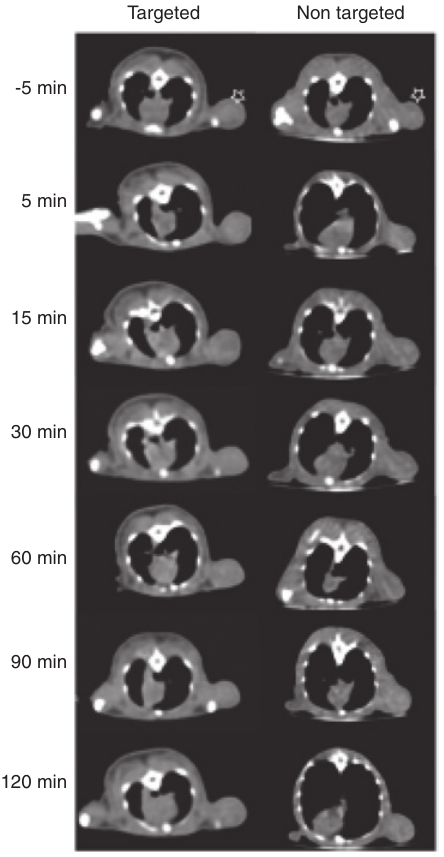
Figure 4: CT images of tumors before and after intravenous injec- tion of DSNP with (targeted, left) or without FA (nontargeted, right). The stars indicate the tumor area. Reproduced from Ref. (69). Copy- right ©2013, WILEYVCH Verlag GmbH & Co. KGaA,